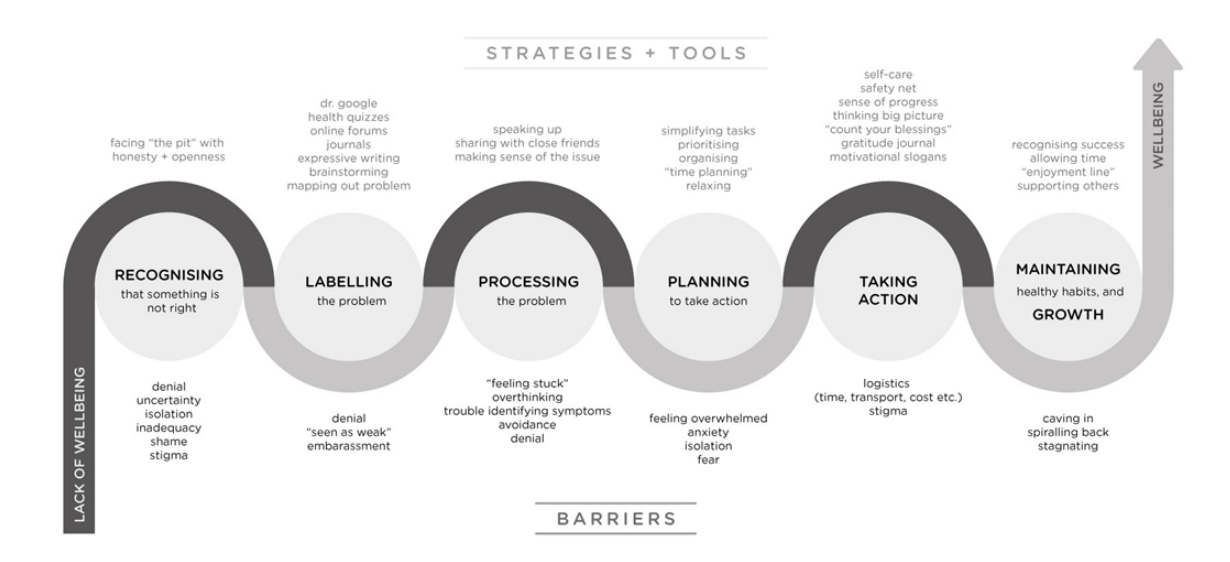
Figure 2. Young people’s journey toward well-being.